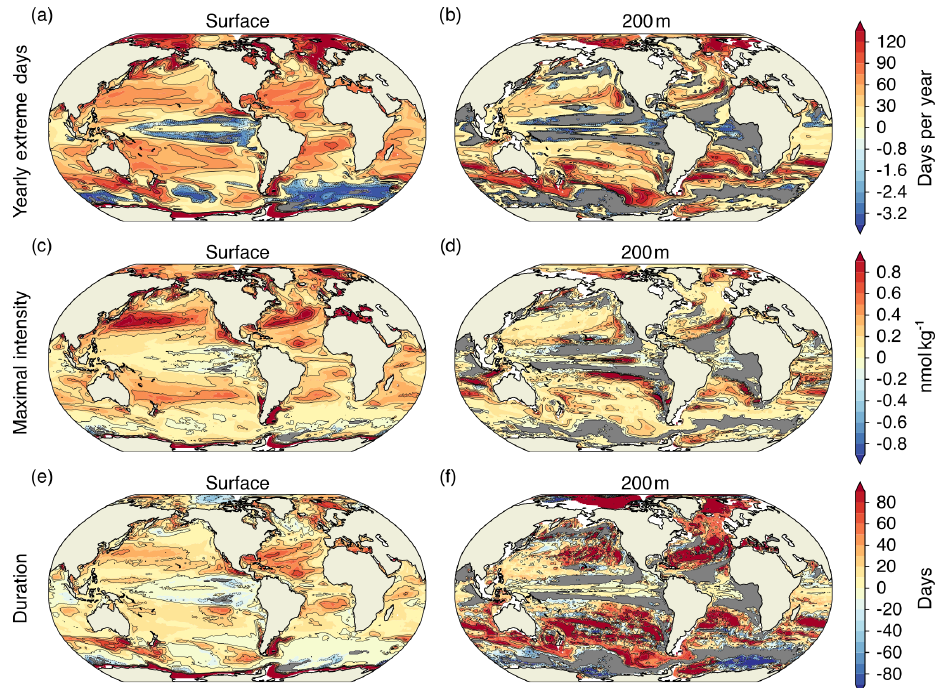
Figure 7. Simulated regional changes in [H + ] extreme-event characteristics from the preindustrial period to the 2081–2100 period under the RCP8.5 scenario at the surface and at depth for the yearly extreme days (a, b) , the maximal intensity of events (c, d) , and the duration of events (e, f) . The extreme events are defined with respect to a shifting baseline. Shown are changes averaged over all five ensemble members. Gray colors represent areas where no extremes occur during 2081–2100, and the black lines highlight pattern structures.